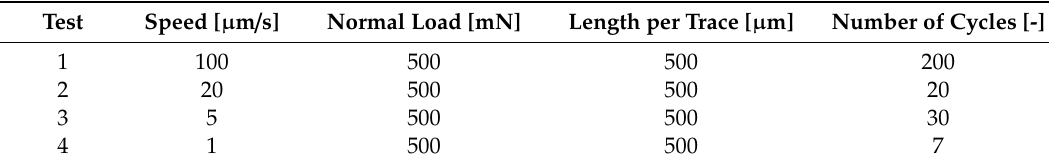
Table 1. Test parameters of stick-slip tests.